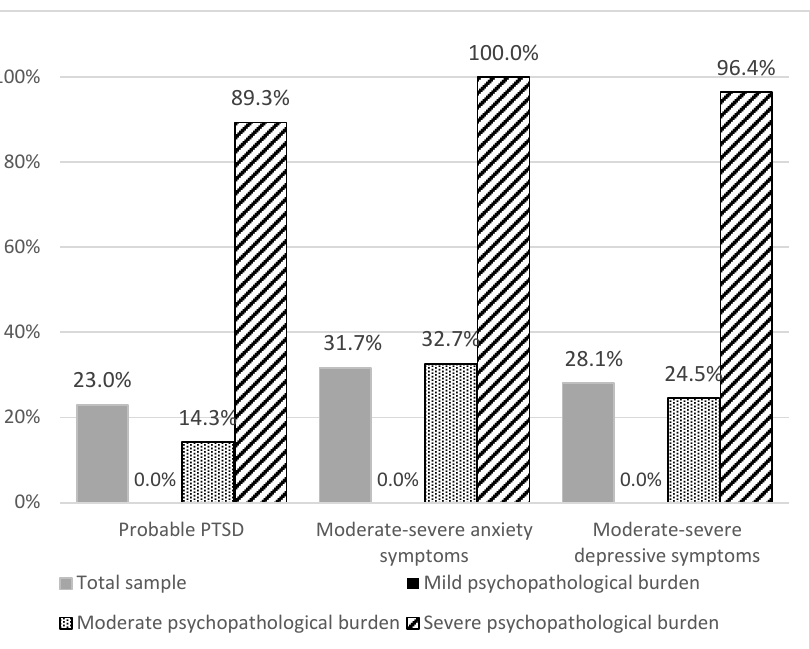
Figure 1. Prevalence of PTSD, Anxiety and Depressive symptoms by means of the IES ‐ R, GAD ‐ 7 and PHQ ‐ 9 scores in the Mild psychopathological burden ( n = 62), Moderate psychopathological burden ( n = 49) and Severe psychopathological burden ( n = 28) groups.